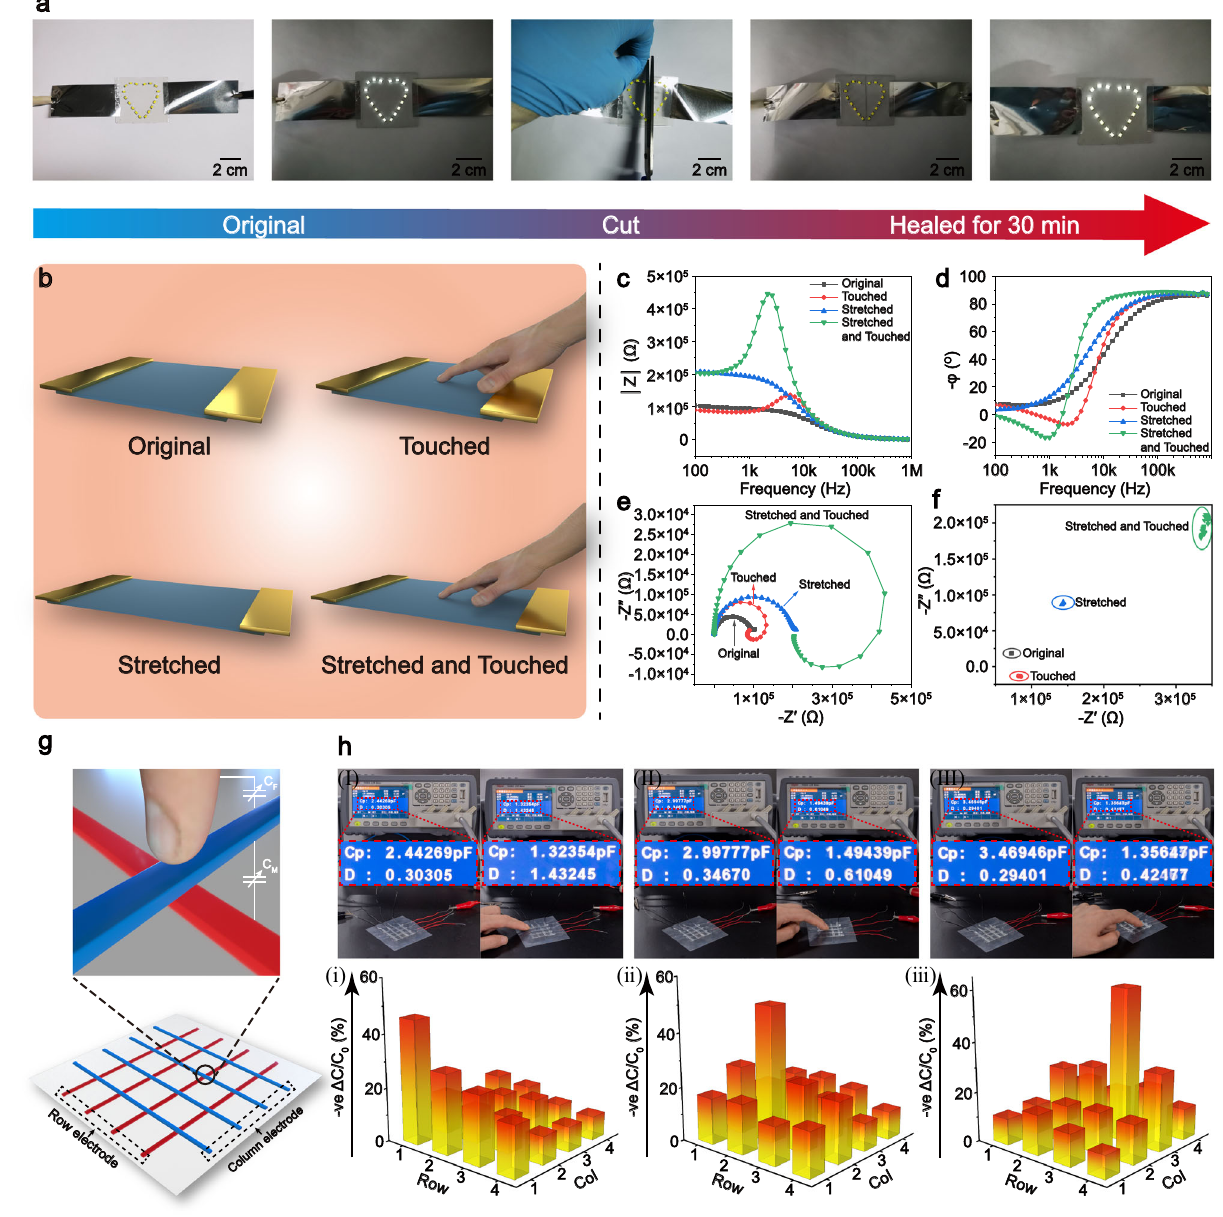
Fig. 6 | DSICE-based fl exible conductive substrate and touch sensor. a Visually demonstration of DSICE as conductive substrate with excellent self-healing capa- city to extend the service life. From left to right: A heart-shaped pattern with 18 LEDs was created; LEDs were lit in an AC 220 V electric fi eld; DSICE-30 sample was cut from the middle of the heart-shaped pattern, LEDs were out; after self-healed for30min,LEDswerelitagain. b SchematicdiagramoftheDSICEimpedance-based touch sensor at different states (original, touched, stretched, stretched and tou- ched). c Plots of impedance magnitude (|Z|) versus testing frequency of touch sensor at different states. d Negative phase angle (- ϕ ) versus testing frequency of